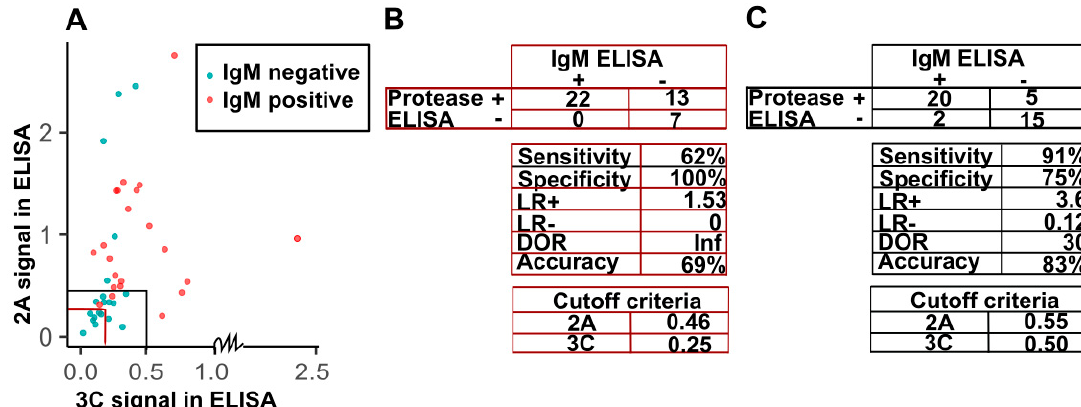
Figure 5. Acute enterovirus infection criteria and test descriptors based on ELISA results. ( A ) Different cutoff criteria based on 2A and 3C signals (based on 6-month children average + 3 × SD ( n = 20) or the adjusted thresholds) and IgM positivity. In the plot ( A ), IgM positive data points are colored red and control data points are cyan. ( B ) Confusion matrix and test descriptors calculated from the traditional cutoff values based on results from 6-month children comparing the new protease-ELISA test to the IgM ELISA by analysis in R. Sensitivity is the proportion of true positives and specificity is the proportion of true negatives correctly categorized with respect to IgM ELISA by the protease ELISA. LR+ and LR– stand for positive and negative likelihood ratios respectively and DOR the overall diagnostic odds ratio. ( C ) Confusion matrix and test descriptors based on the adjusted diagnosis criteria.